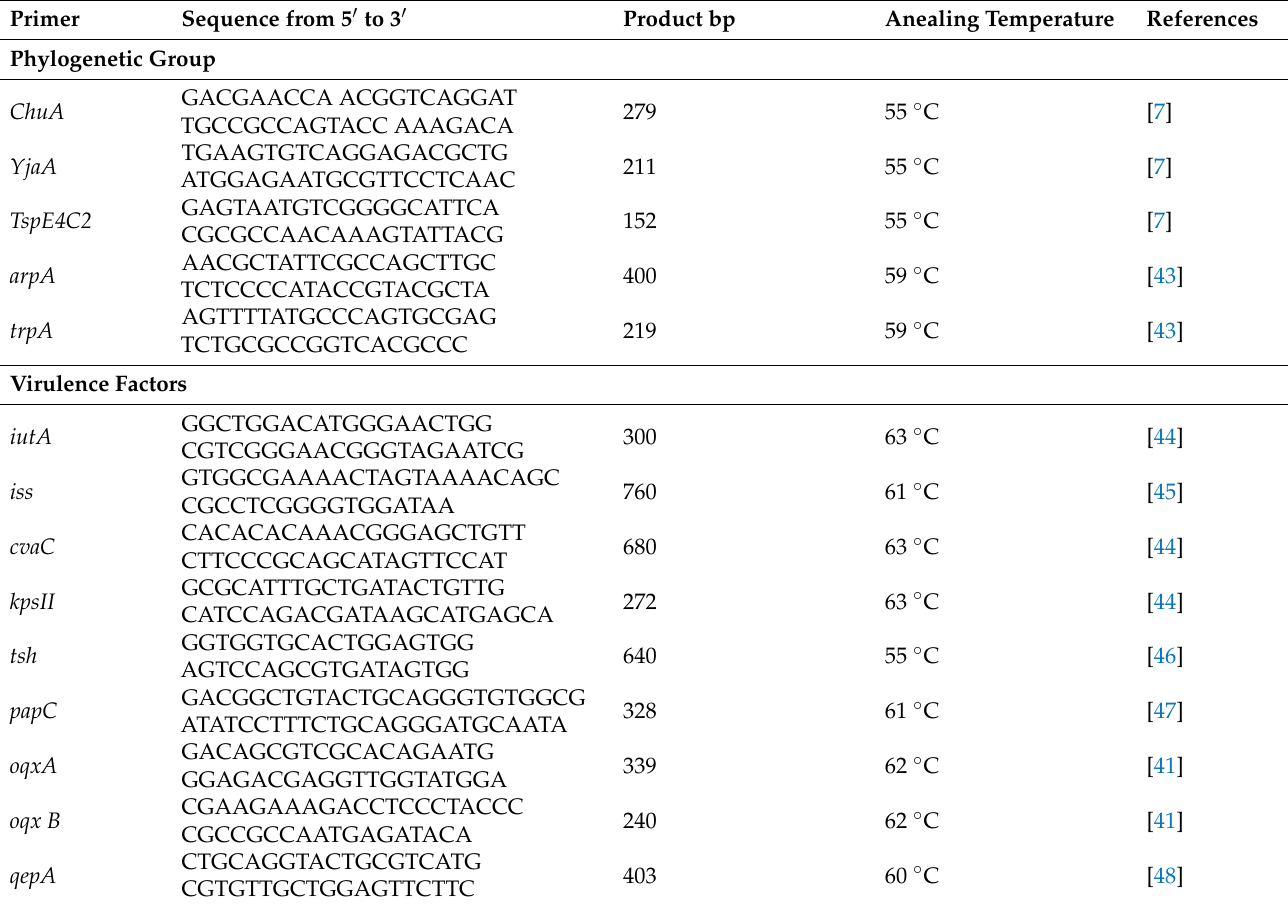
Table 3. Used primers and PCR conditions for the detection of phylogenetic groups and virulence factors.